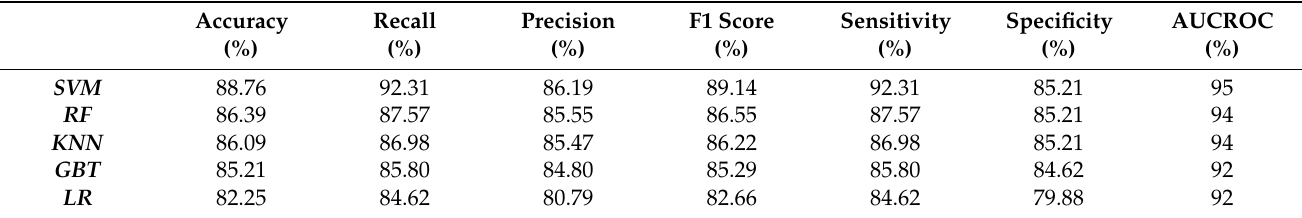
Table 4. Performance in the prediction of the employed